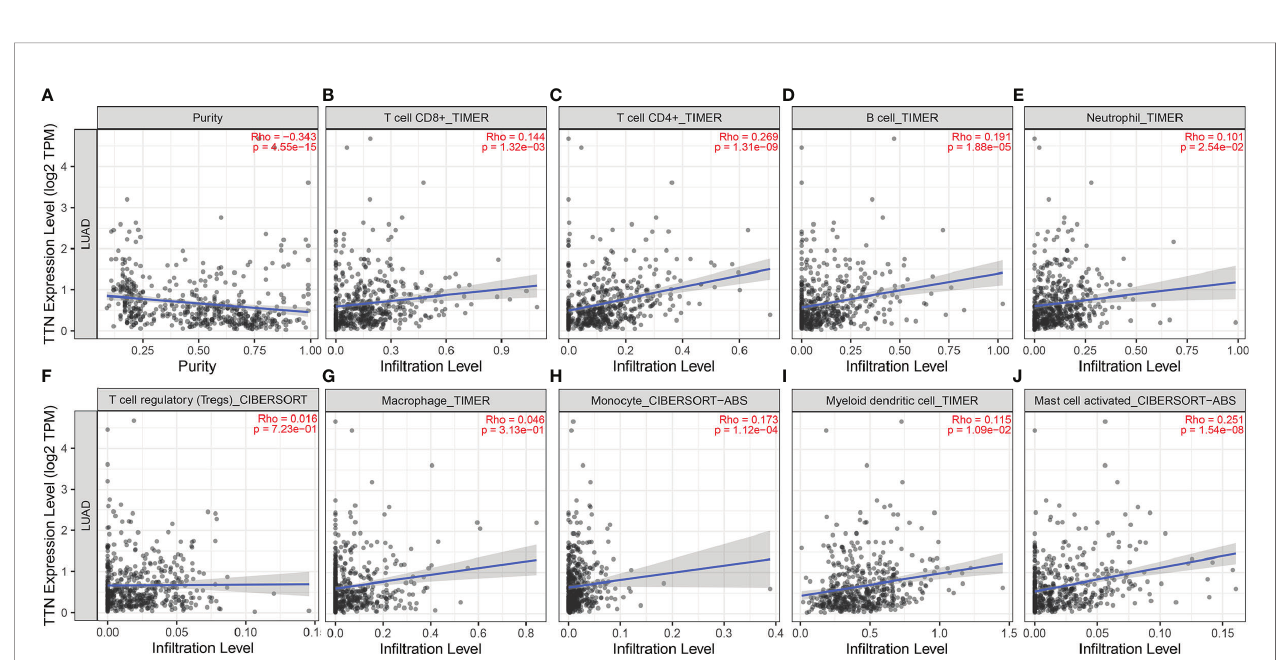
FIGURE 6 | Correlations between TTN expression level and tumor-in fi ltrating immune cells in LUAD. TTN expression displayed signi fi cant correlations with tumor purity (A) and in fi ltration of CD8+T cells (B) , CD4+T cells (C) , B cells (D) , neutrophils (E) , monocytes (H) , DCs (I) , and mast cells (J) activated in LUAD. TTN expression showed a very weak correlation with Treg (F) and macrophages (G) in